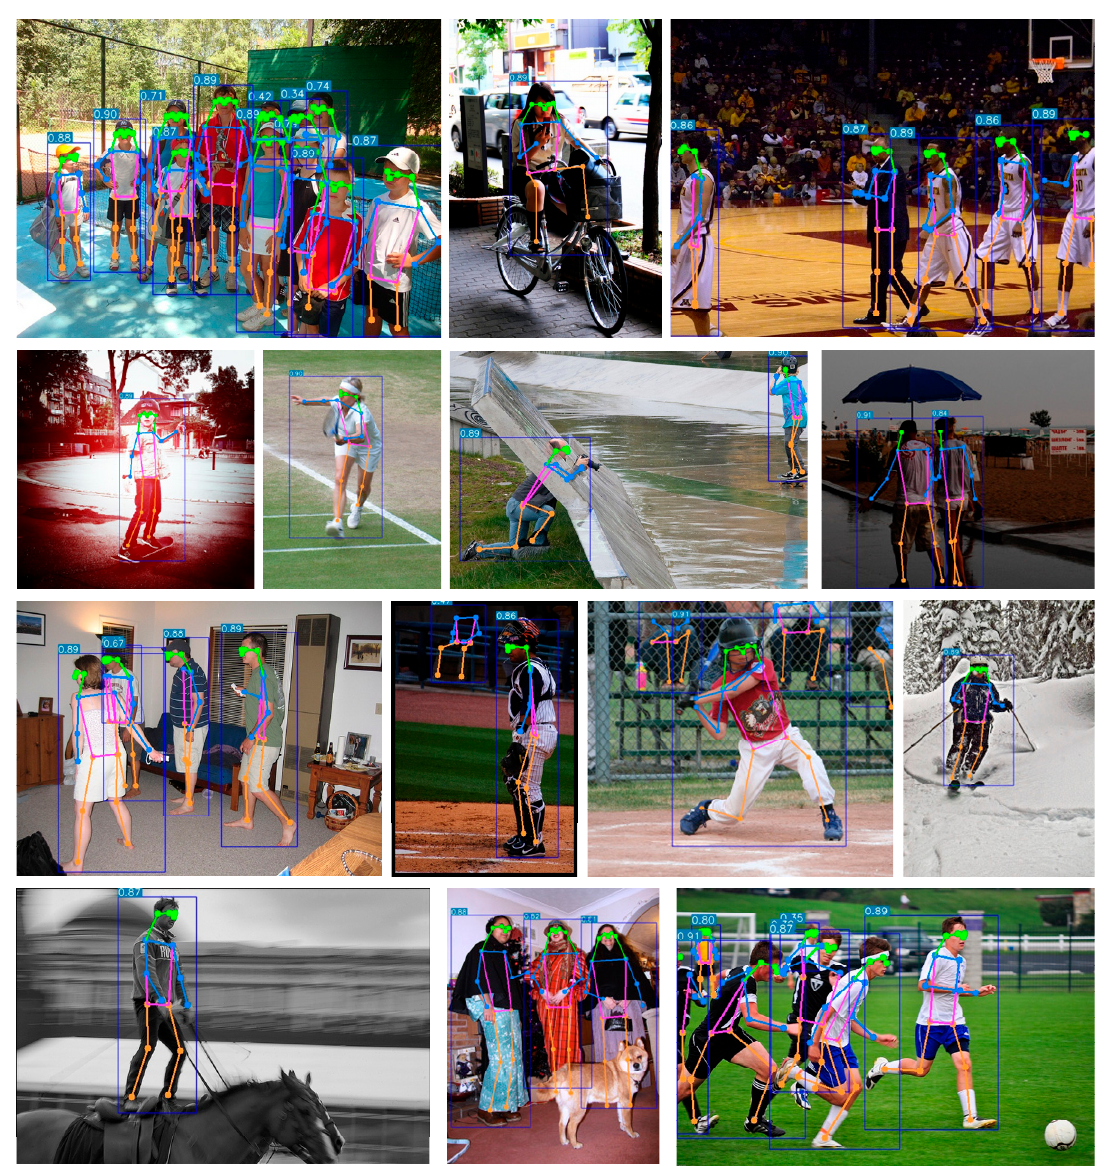
Figure 10. Pose estimation results on COCO 2017.